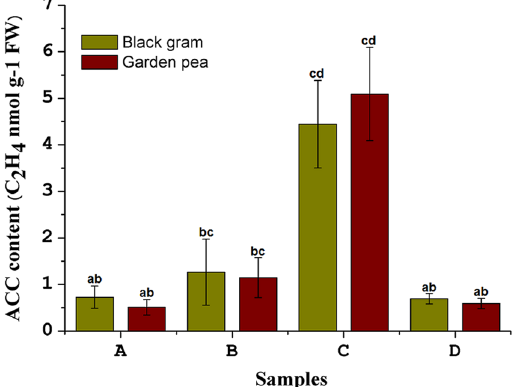
Figure 4. 1-aminocyclopropane-1-carboxylic acid (ACC) content in the root tips of black gram and garden pea plants growing under different treatment condition. The quantification was carried out on 45 th day of stress induction. Treatments: A- uninoculated watered plants as positive control, B-consortium ( Ochrobactrum pseudogrignonense RJ12 + Bacillus subtilis RJ46 + Pseudomonas sp.RJ15) inoculated plants with drought stress induction, C- uninoculated plants under drought stress as negative control, D – consortium ( Ochrobactrum pseudogrignonense RJ12 + Bacillus subtilis RJ46 + Pseudomonas sp.RJ15) inoculated with sufficient water supply. Two- way ANOVA was performed considering water supply and bacteria inoculation as two independent variables followed by Tukey’s post-test for each treatment. Different symbols on bars indicates a significant difference at p = 0.05 in ACC accumulation under different treatment